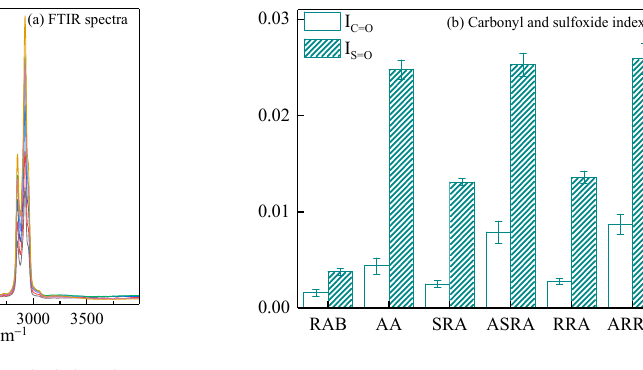
(b)Correlation between G * /sin δ and SE, Ra, I Aging .